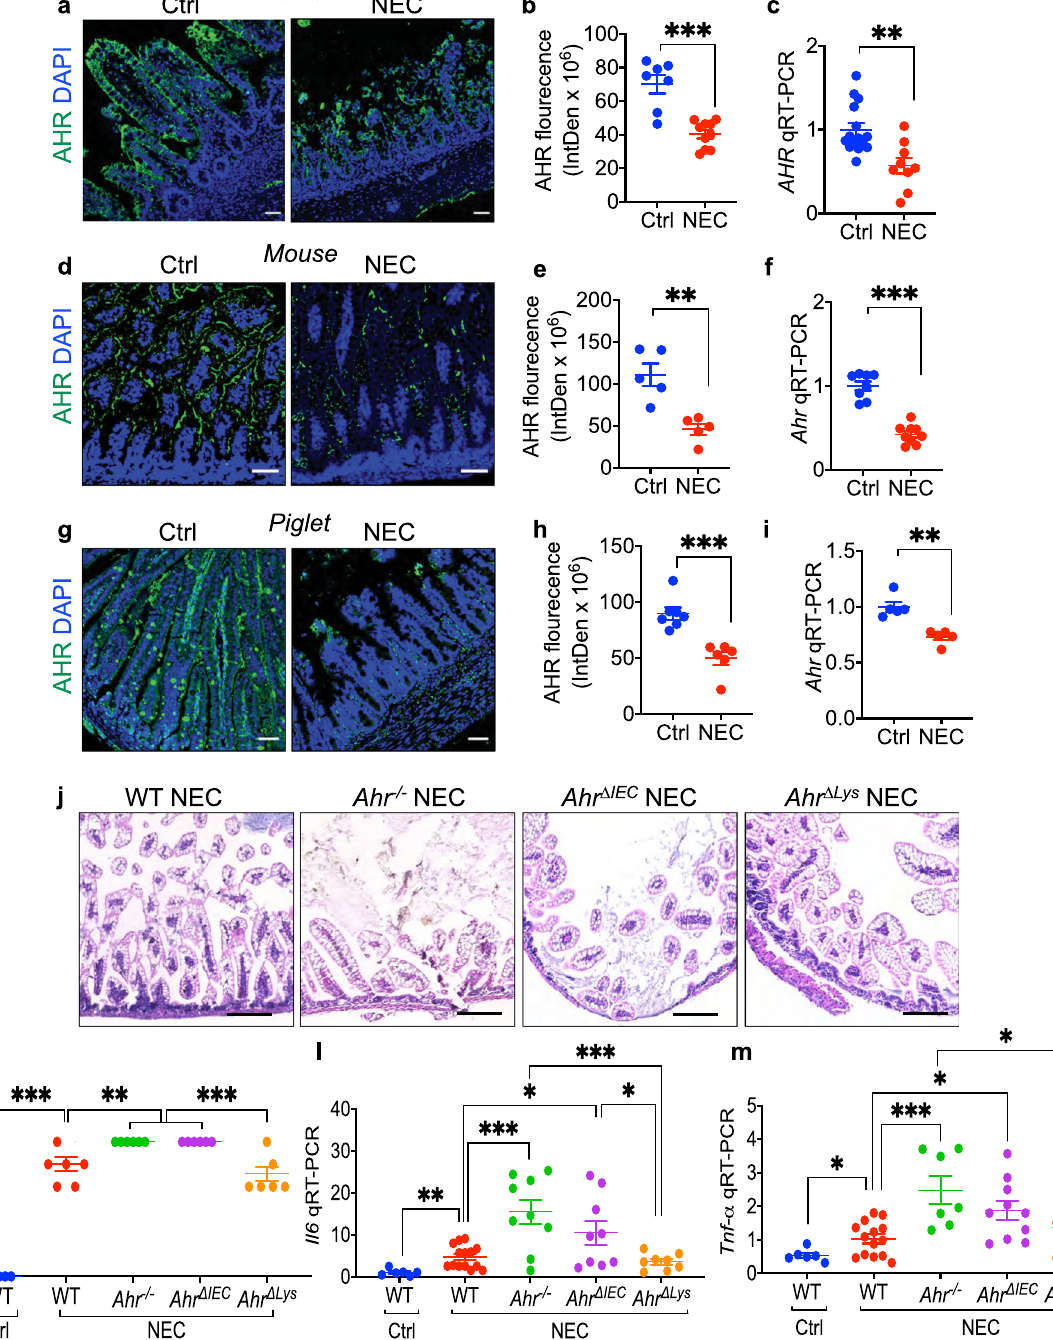
Fig. 2 AHR expression on the the intestinal epithelium is required for protection against NEC. a , b , d , e , g , h Representative confocal images and quanti fi cation of fl uorescent intensity of AHR immuno-stained ileal sections of human ( a , b , n = 7, 10 ileal section, p < 0.0001), mouse ( d , e , n = 5, 5 ileal section, p = 0.0025), p iglet ( g , h , n = 7, 6 ileal section, p = 0.0004) ileal specimens from control (Ctrl) and NEC patients or animals. AHR, green signal; nuclei (DAPI, blue signal). c , f , i Express i on of Ahr by qRT-PCR in the small intestine of human ( c , n = 15, 9 human specimens, p = 0.0019), mouse ( f , n = 8, 9 mice, p < 0.0001), and piglets ( i , n = 5, 5 piglets, p = 0.0010). j H&E-stained representative images showing abnormal NEC histology in mice induced to develop experimental NEC in wild-type (WT), AHR knockout ( Ahr -/- ), AHR intestinal epithelial cells knockout ( Ahr Δ IEC ), and AHR myeloid knockout ( Ahr Δ lys ) mice. k Quanti fi cation of NEC severity ( n = 7, 7, 7, 7, 7 mice, WT Ctrl vs WT NEC, p < 0.0001, WT NEC vs Ahr -/- NEC p = 0.0074, WT NEC vs Ahr Δ IEC NEC p = 0.0074, Ahr -/- NEC vs Ahr Δ lys NEC p = 0.0001, Ahr Δ IEC NEC vs Ahr Δ lys NEC p = 0.0001) . l , m qRT-PCR expression of Il6 ( l , n = 6, 14, 7, 9, 8 mice, WT Ctrl vs WT NEC, p = 0.0048, WT NEC vs Ahr -/- NEC p = 0.0006, WT NEC vs Ahr Δ IEC NEC p = 0.0268, Ahr -/- NEC vs Ahr Δ lys NEC p = 0.0009, Ahr Δ IEC NEC vs Ahr Δ lys NEC p = 0.0415) and Tnf- α ( m , n = 6, 14, 7, 9, 8 mice, WT Ctrl vs WT NEC, p = 0.0350, WT NEC vs Ahr -/- NEC p = 0.0012, WT NEC vs Ahr Δ IEC NEC p = 0.0076, Ahr -/- NEC vs Ahr Δ lys NEC p = 0.0473) in the intestinal epithelium. Scale bars in a , d , g , 50 μ m. Scale bars in j , 100 μ m. All data are presented as mean values ± SEM. * p < 0.05, ** p < 0.01, *** p < 0.001, p values obtained either from two-sided t tests or one-way ANOVA followed by multiple comparisons. Each dot in graphs represents data from an individual ileal section, human specimen, mouse, or piglet. NATURE COMMUNICATIONS| (2021) 12:1042 |https://doi.org/10.1038/s41467-021-21356-4|www.nature.com/naturecommunications